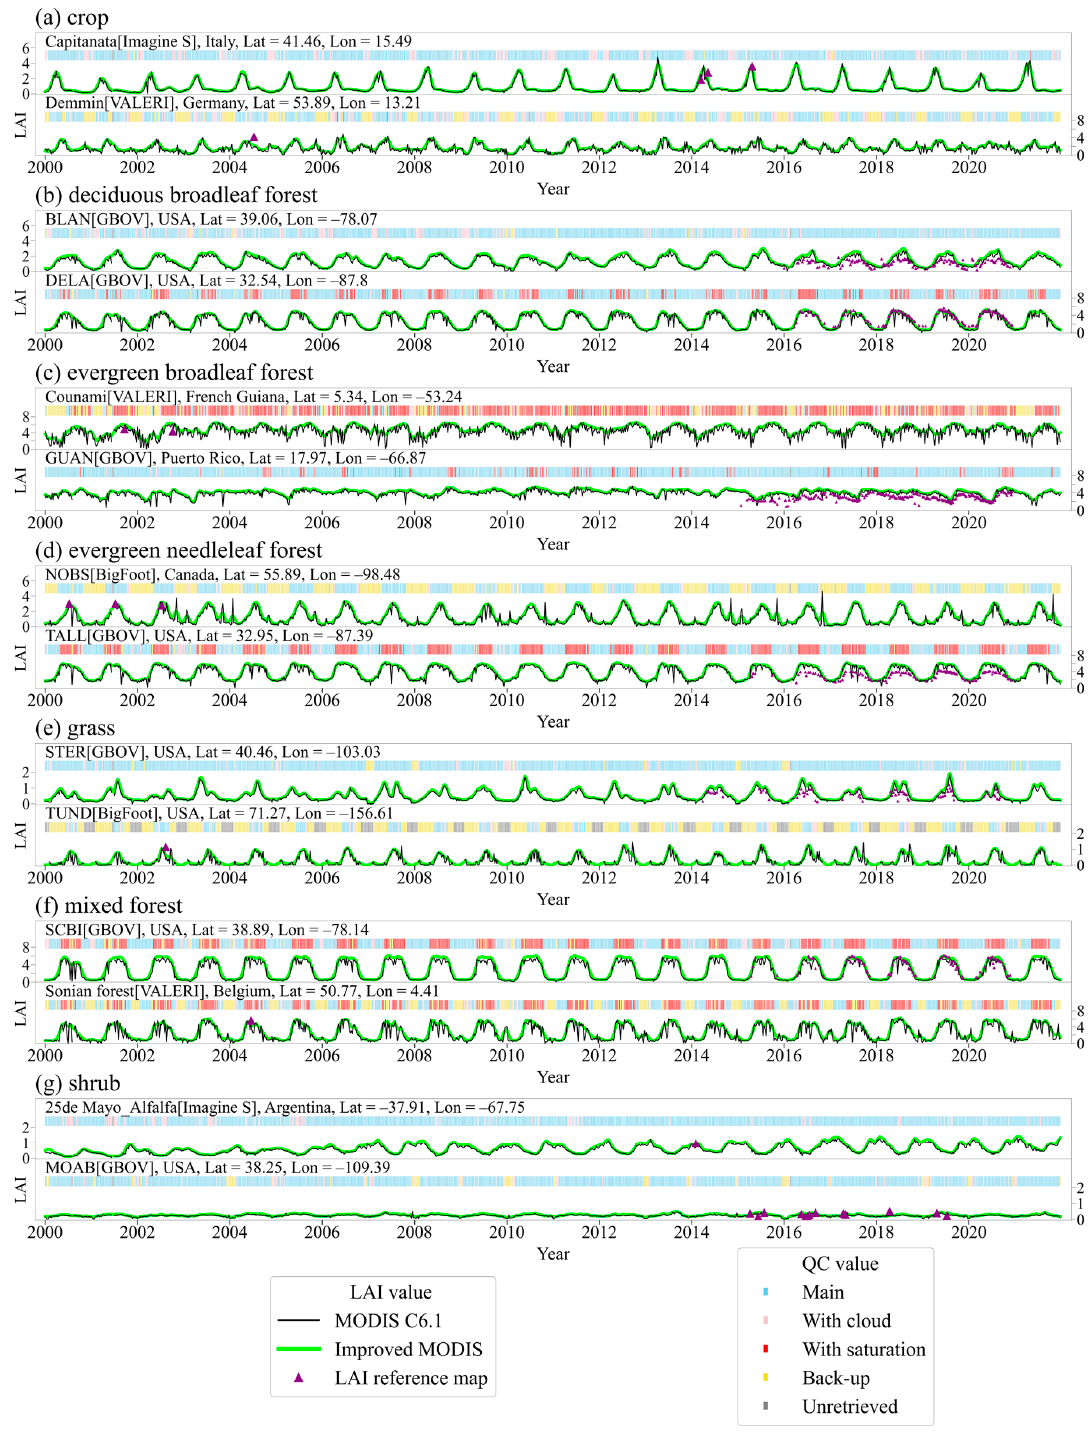
Figure 3. Time series plot of spatial mean MCD15A2H C6.1 LAI and reprocessed MODIS LAI within the reference map extent. MOD15A2H C6.1 LAI was used for the time prior to 26 June 2002, in the cases of the reference map data existing. QC information that indicates retrieval algorithms was plotted above the time series, and corresponded with the five categories listed in Table